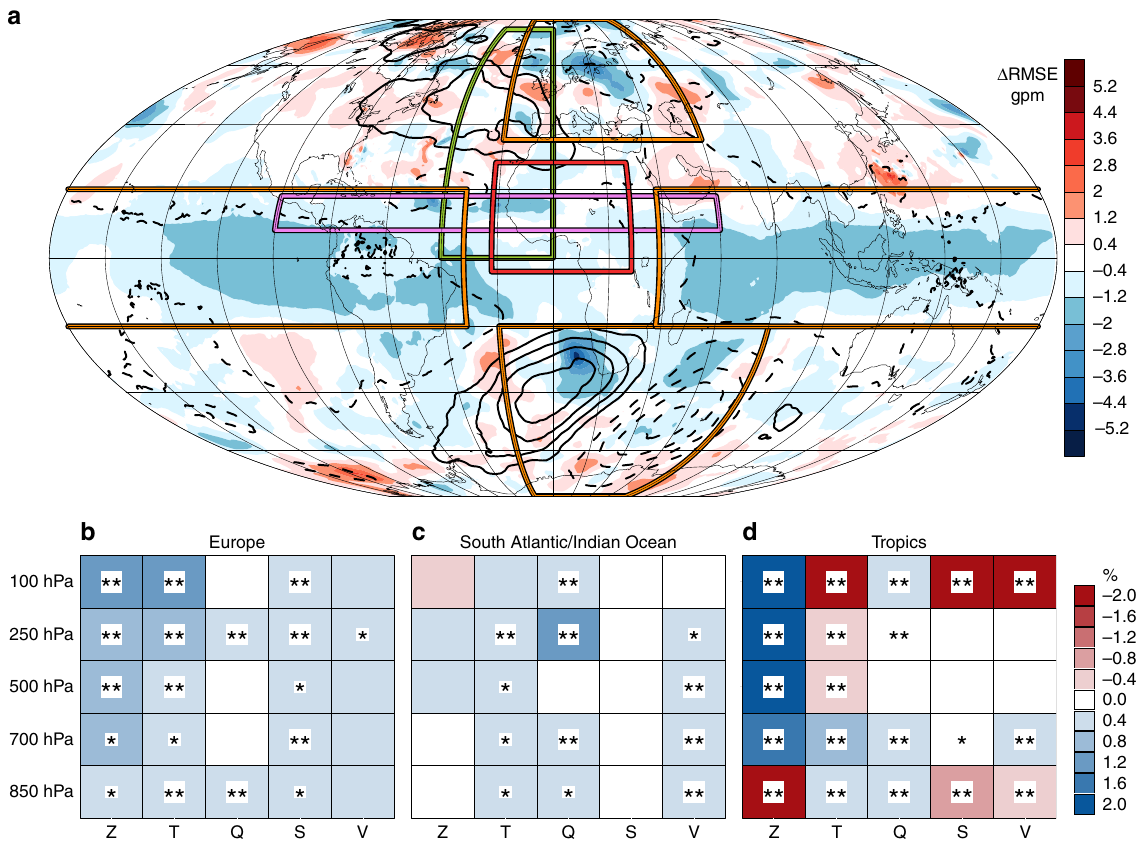
Fig. 3 Impact of resolving Sahelian thunderstorms on global forecasts. a Difference of simulations explicitly resolving convection (EXPLC) minus simulations employing the convection parameterisation (PARAM) of geopotential height at 500 hPa averaged over forecast days 5 – 8. Differences of the root mean squared error (RMSE, shading) and absolute values (black contour lines in ±2 geopotential meter (gpm) intervals, negative dashed) are shown. The two-way nesting domain and the evaluation regions are given as red and orange boxes, respectively. Violet and green boxes mark averaging regions used to analyse signal propagation in zonal and meridional direction. b – d Relative improvement of the RMSE (i.e. (RMSE(EXPLC) − RMSE(PARAM))/ RMSE(PARAM) ×100) in the European ( b ), South Atlantic/Indian Ocean ( c ) and tropical ( d ) evaluation regions, averaged over forecast days 5 – 8 for the variables geopotential ( Z ), temperature ( T ), speci fi c humidity ( Q ), wind speed ( S ) and wind vector ( V ) at fi ve different pressure levels. Double asterisks and single asterisks symbol denotes statistical signi fi cant differences between EXPLC and PARAM on the α = 5% (20%) level. Blue denotes an improvement in EXPLC compared to PARAM, and red a deterioration. Time averaging considers the autocorrelation of the differences between EXPLC ’ s and PARAM ’ s RMSE (see